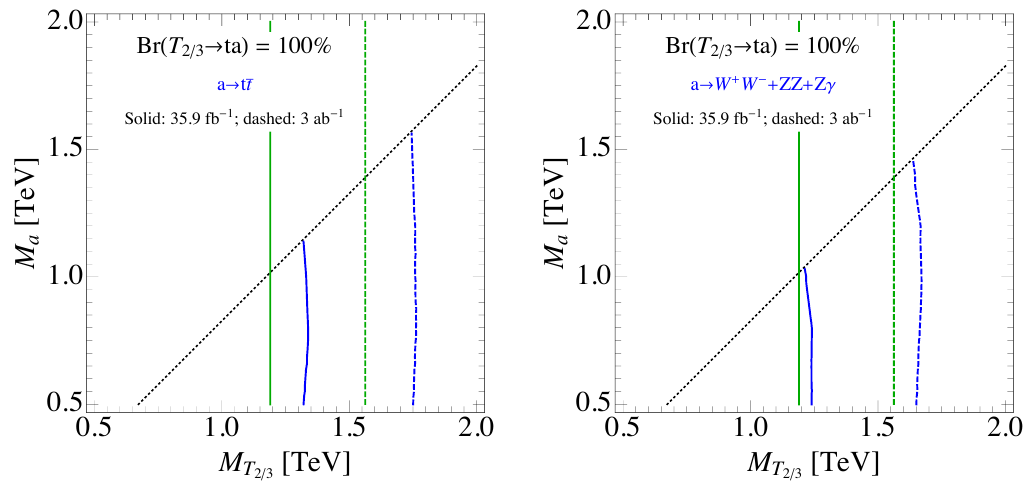
Figure 8 . Bounds on the M T { M a plane from the CMS SSL search of ref. [10] (solid lines) and 2 = 3 projections for the HL-LHC reach (dashed lines). On the left we show the exotic decay T ! ta ! 2 = 3 tt (cid:22) t , on the right the exotic decay T ! ta ! tW + W (cid:0) assuming the photo-phobic benchmark 2 = 3 model with (cid:20) B = (cid:0) (cid:20) W . The bounds and projections for X pair-production with Br( X ! 5 = 3 5 = 3 tW + ) = 1 are shown for reference in green lines. The bounds become insensitive to M a for light masses above